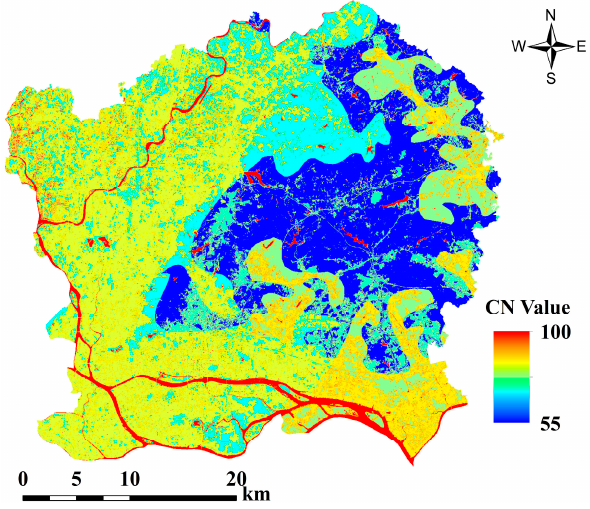
Figure 11. CN map of vegetation in this study.